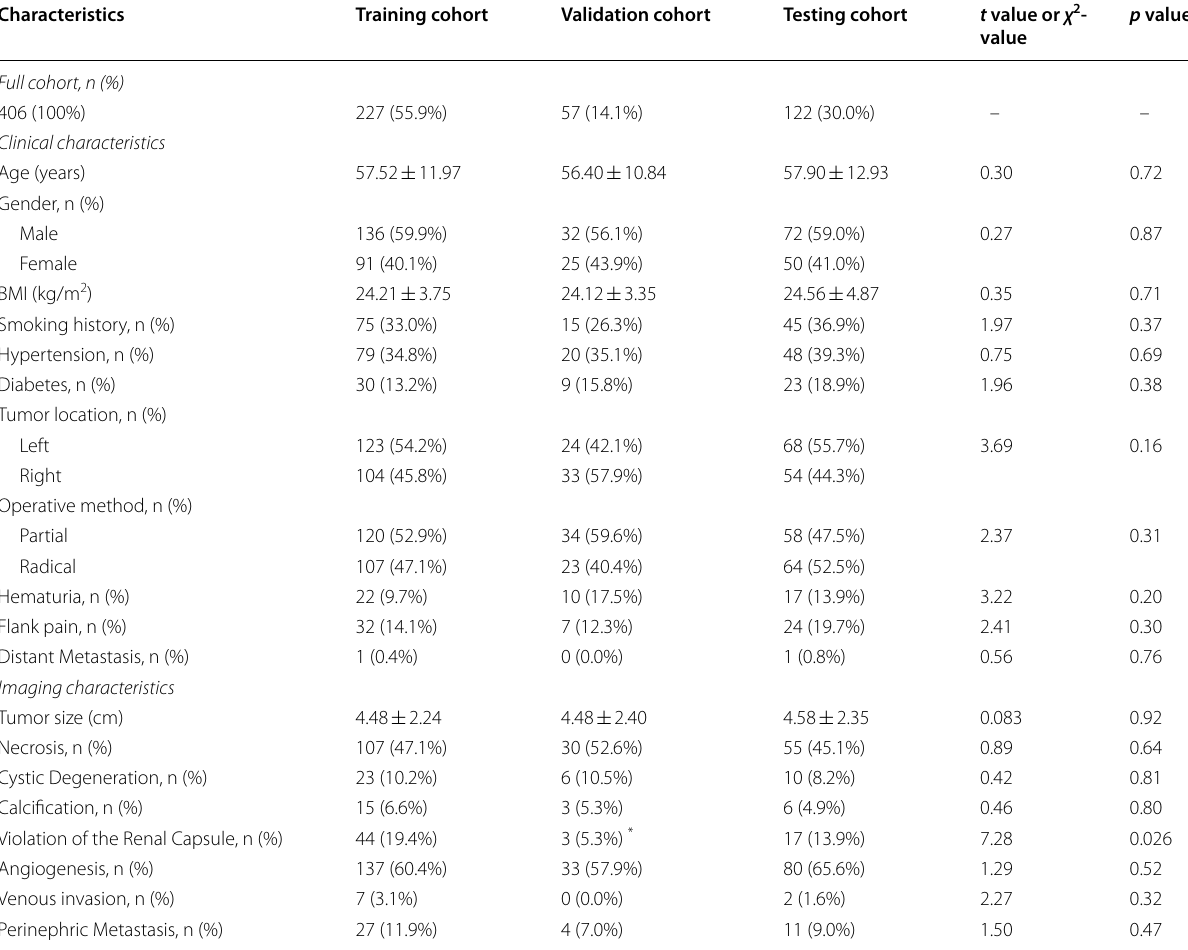
* p < 0.05 for the comparison with patients in the training set